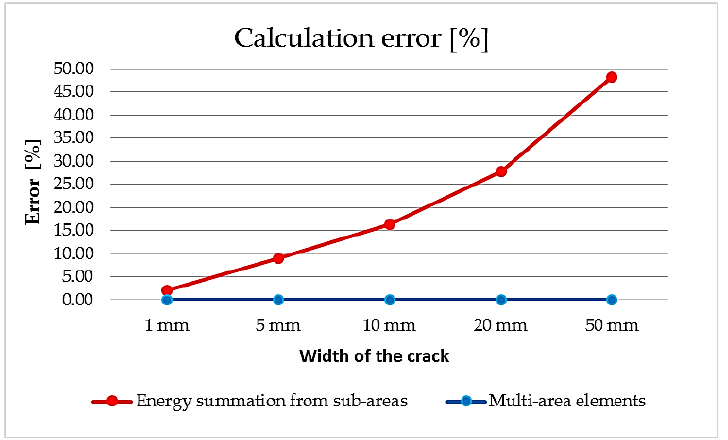
Figure 5. Diagram of the calculation error.